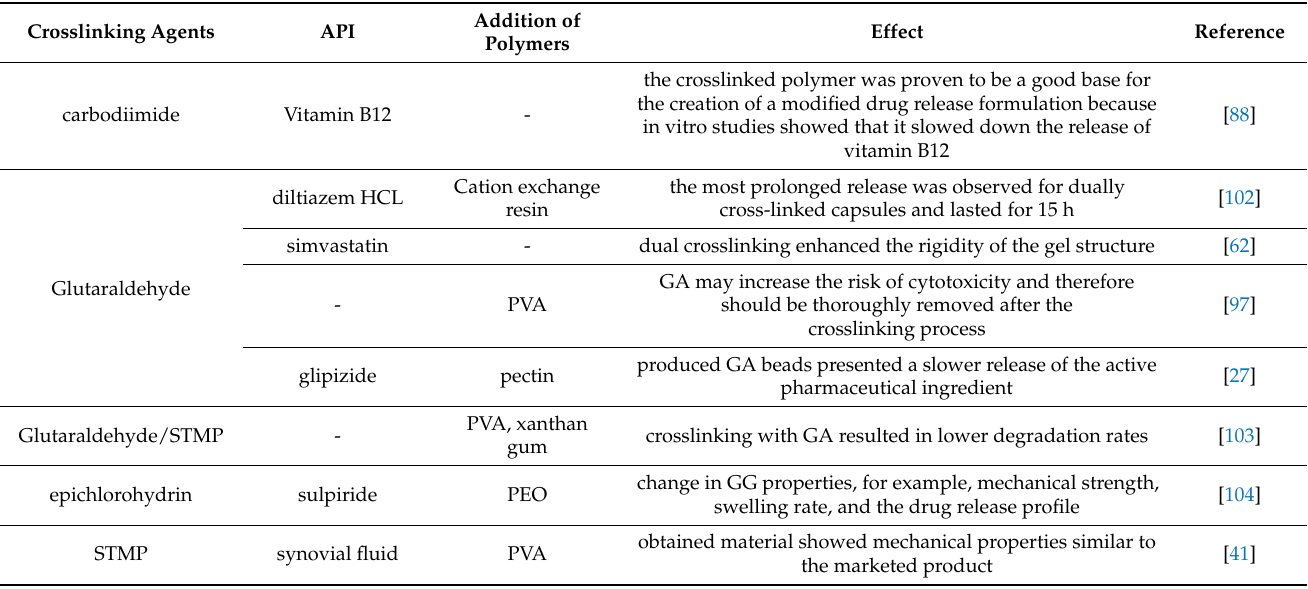
Table 2. Examples of drug delivery systems obtained by chemical